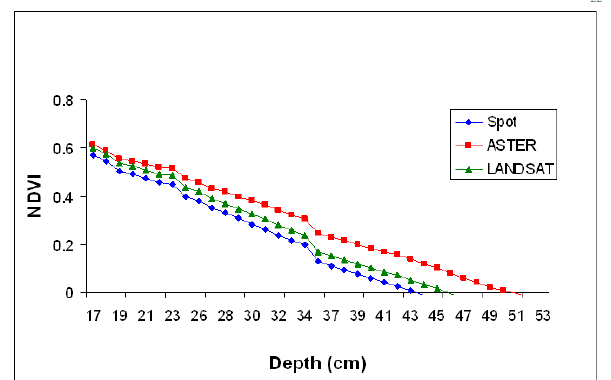
Figure 9 : Water depth-induced changes in the Normalized Difference Vegetation Index (NDVI) values calculated with the reflectance values integrated to match the red and NIR (near infrared) bands of the sensors of the three satellite (Landsat7, ASTER, and SPOT5).